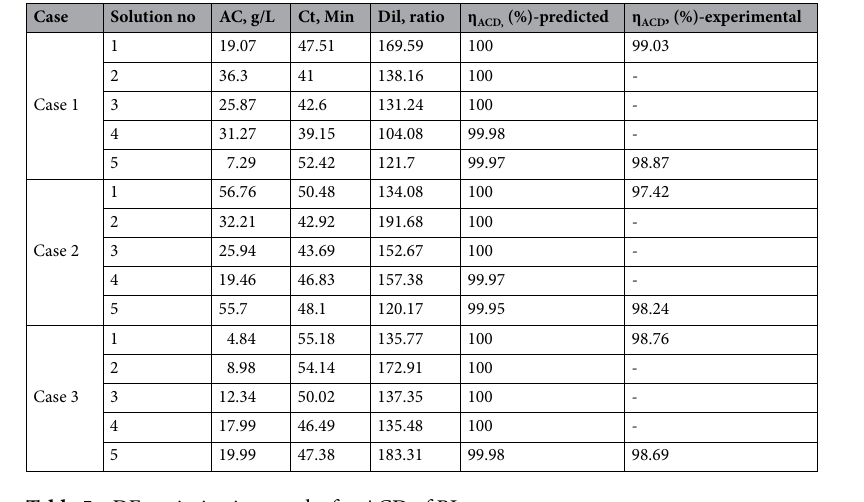
Table 5. DE optimization results for ACD of BL.